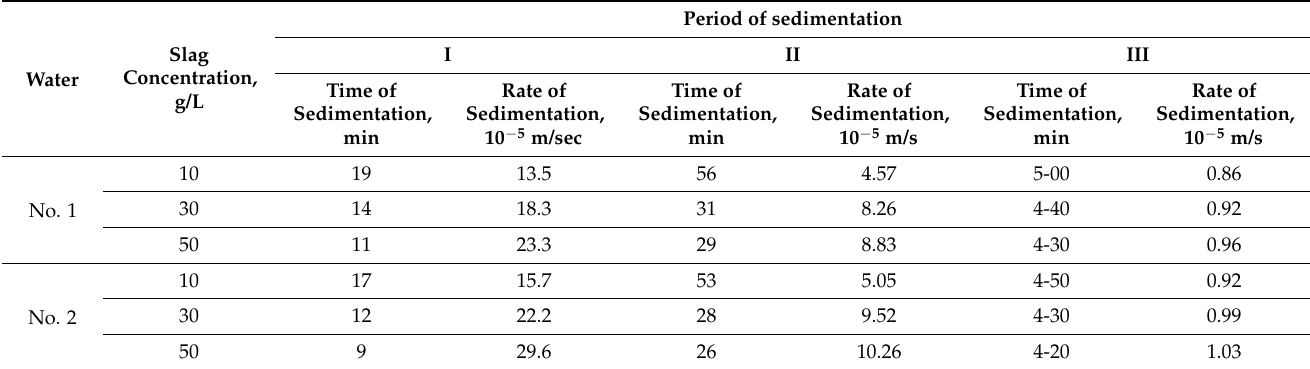
Table 18. Time and rate of sedimentation of slag particles in water dispersed media of different hardness after ultrasonic processing.